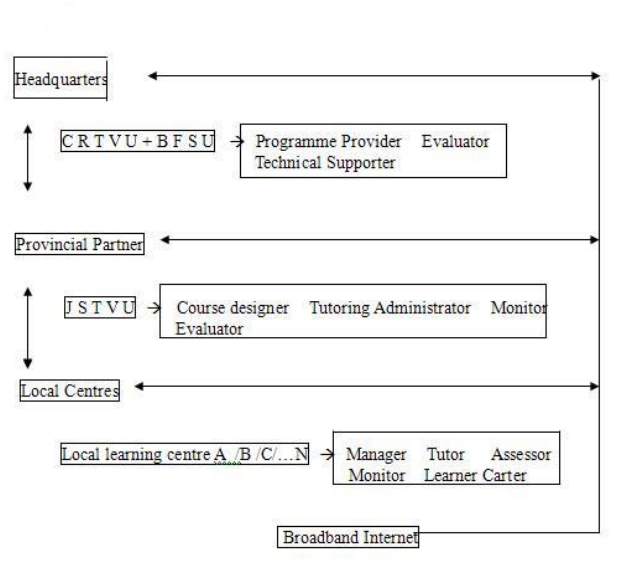
Figure 1. The organizational structure of the three partner